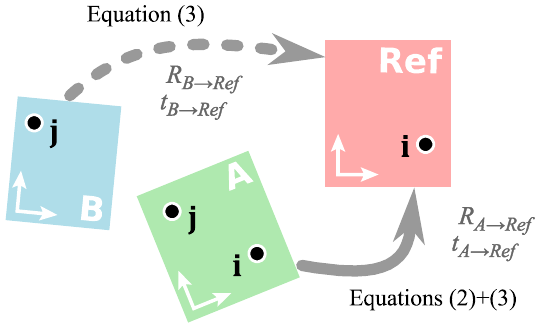
Figure 1. Direct and indirect connections between moving point clouds and the reference